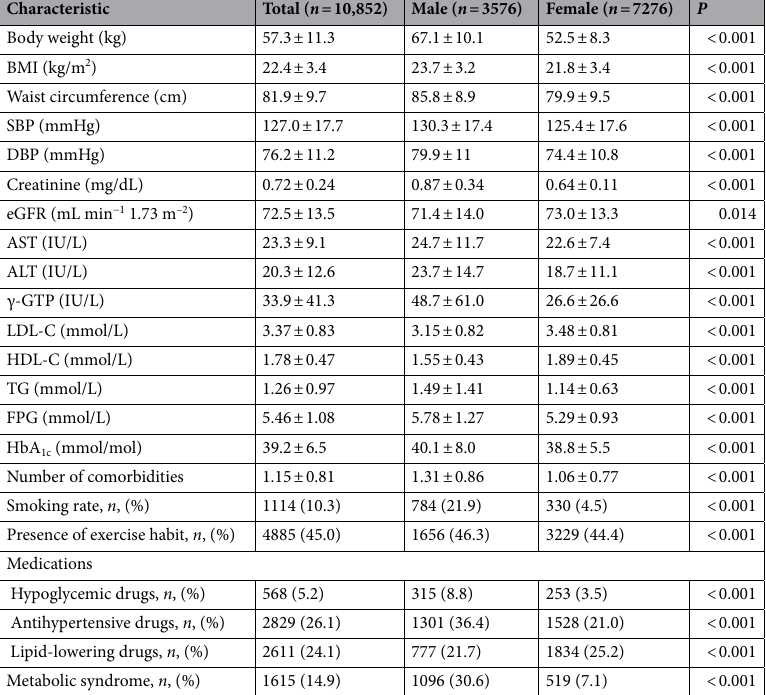
Table 1. Characteristics of the study participants. Data are means ± SD or n (%). All abbreviations are defined in the text. P values for comparisons between males and females were calculated with Student’s t test or the Mann–Whitney U test as